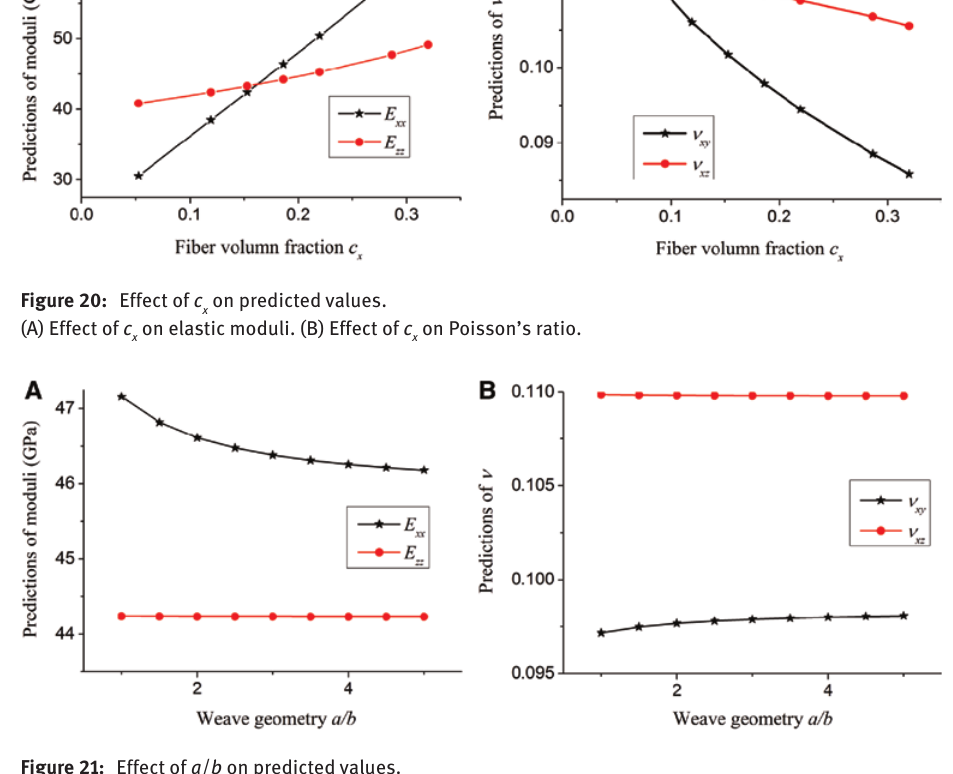
Figure 21: Effect of a / b on predicted